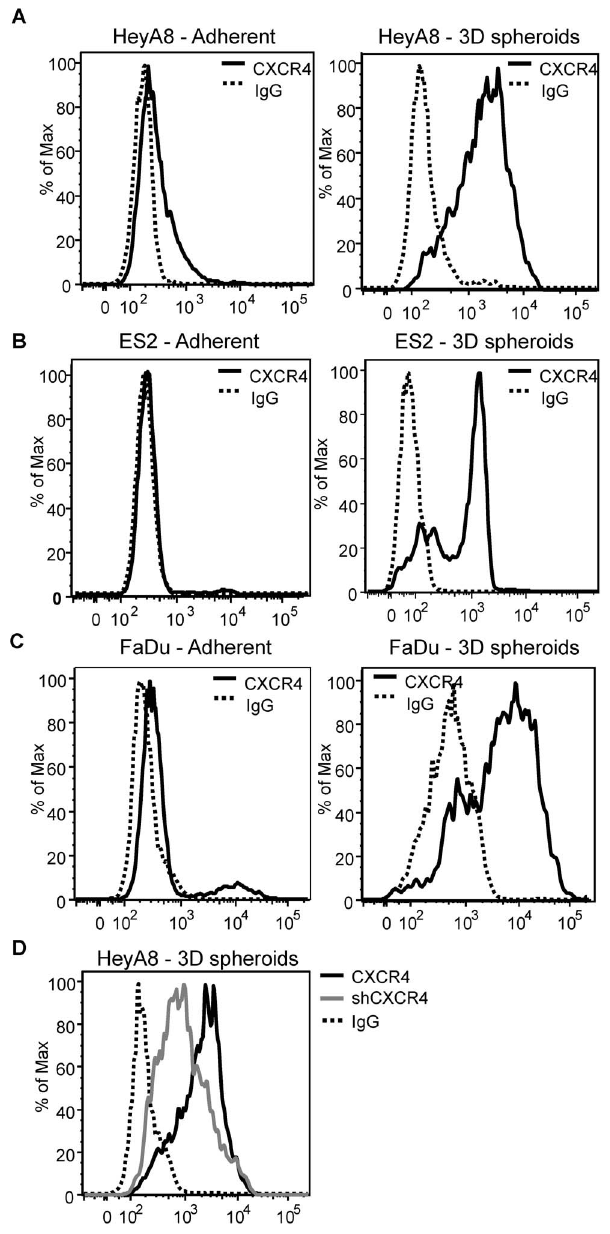
Fig. 2. 3D spheroid culture condition enhances CXCR4 surface expression. Cell lines were cultured as 3D spheroids as described in materials and methods and dissociated using accutase cell dissociating buffer for 10 minutes for flow cytometry analysis. 250,000 cells were used for the flow cytometry analysis. ( A ) HeyA8, ( B ) ES-2, and ( C ) FaDu cells showed low levels of detectable surface CXCR4 when compared to control human IgG under normal adherent culturing conditions. When grown under 3D spheroids, all of the cell lines showed a dramatic shift in CXCR4 surface expression. ( D ) Tet-inducible shRNA knockdown of CXCR4 (shCXCR4) in HeyA8 cells under 3D spheroid condition showed decreased CXCR4 surface expression (Grey line) indicating the specificity of increased CXCR4 surface expression under 3D spheroids. Flow cytometry of CXCR4 expressions in 3D spheroids were pooled representative cells isolated from at least 10 individual spheroids. Each flow graph is representative of 3 (ES2 and FaDu) or 4 (HeyA8) separate